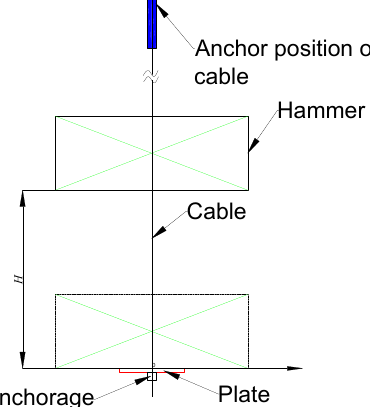
Figure 3. The energy storage stage of hammer lifted.